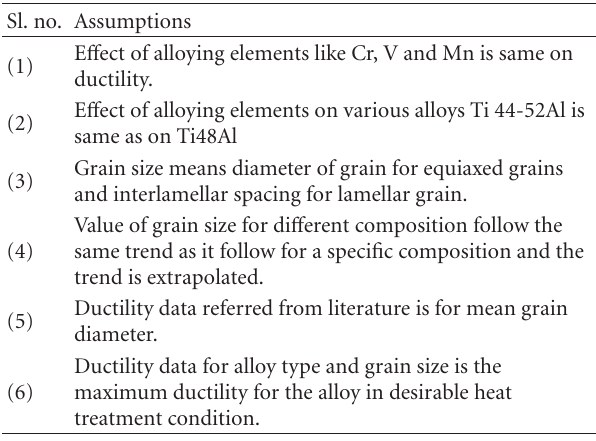
Table 1: Assumptions for categorizing literature